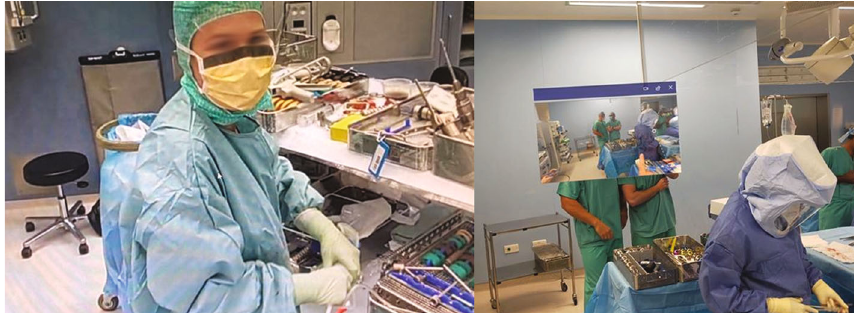
Figure 4: Examples of the product manager ’ s view of a remote operating room through the HoloLens worn by the surgeon.